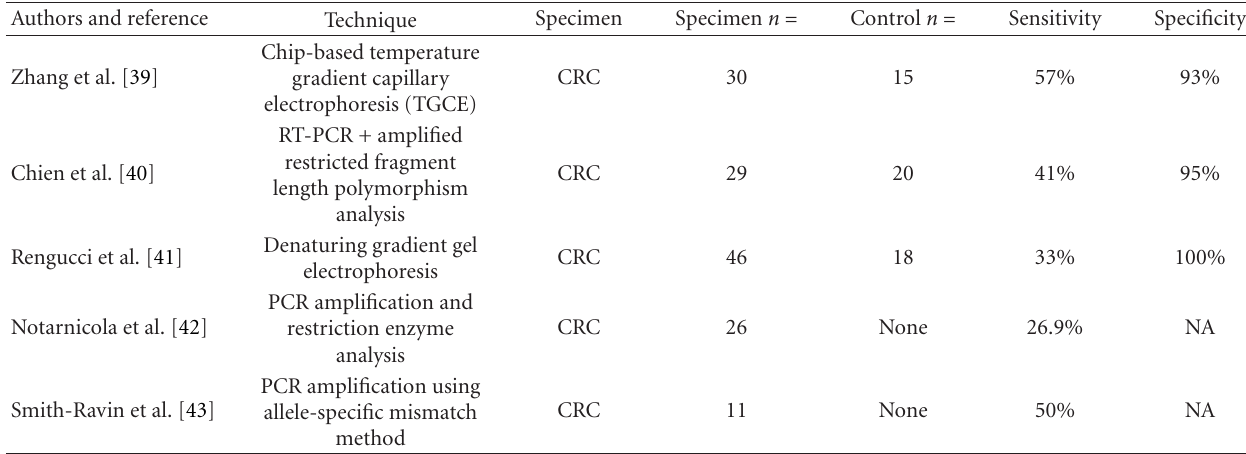
Table 1: Studies of KRAS genetic alterations in fecal